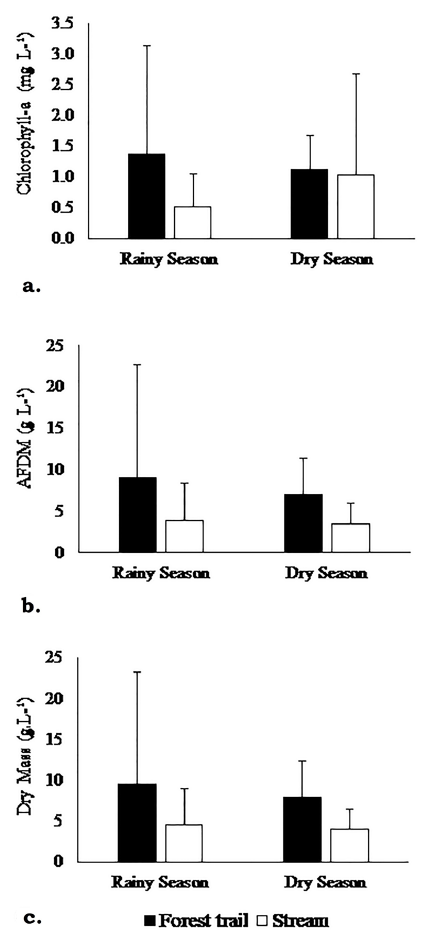
Figure 3. Chlorophyll- a (a) ash-free dry mass (b, AFDM) and dry mass (c, DM) (Mean; ±SD; n = 12) in the phytotelmata of Nidularium longiflorum at the sampling sites near the forest trail and stream in rainy and dry seasons.